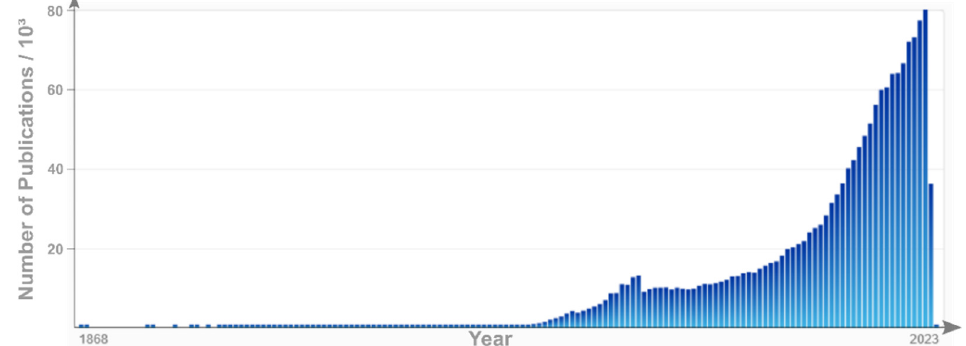
Figure 2. Growing number of scientific publications concerned with infrared spectroscopy. Results were retrieved from a SciFinder search querying for the term “infrared”, limiting the results to scientific journal publications. With a total number of over 1.2 M publications, the growth of infrared-related topics from the year 1924 to 2022 (2023 preliminary) is clearly evident. CAplus. CAS. https://scifinder.cas.org/ (accessed on 6 May 2022).